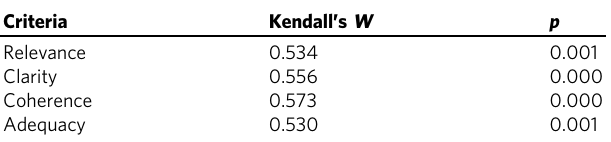
Table 2 Kendall ’ s w test. coef fi cient of concordance.